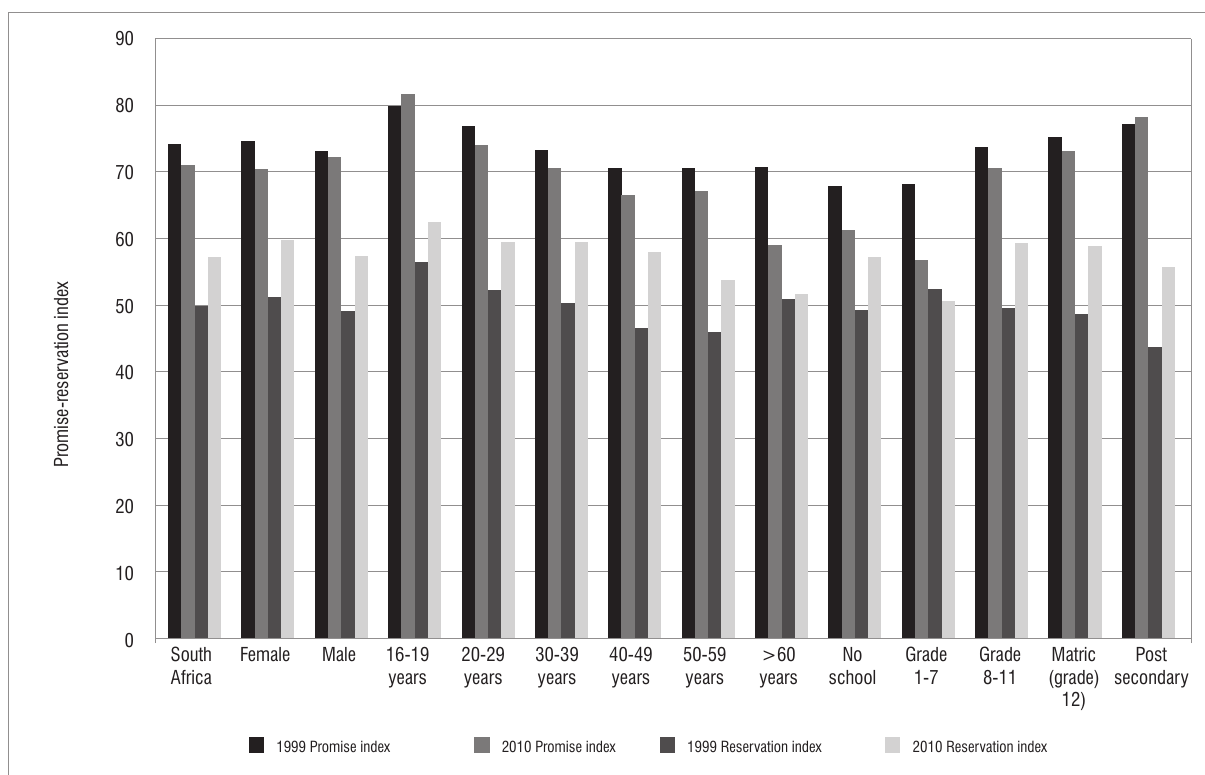
Figure 4: Promise and reservation indices by gender, age and educational level for 1999 and